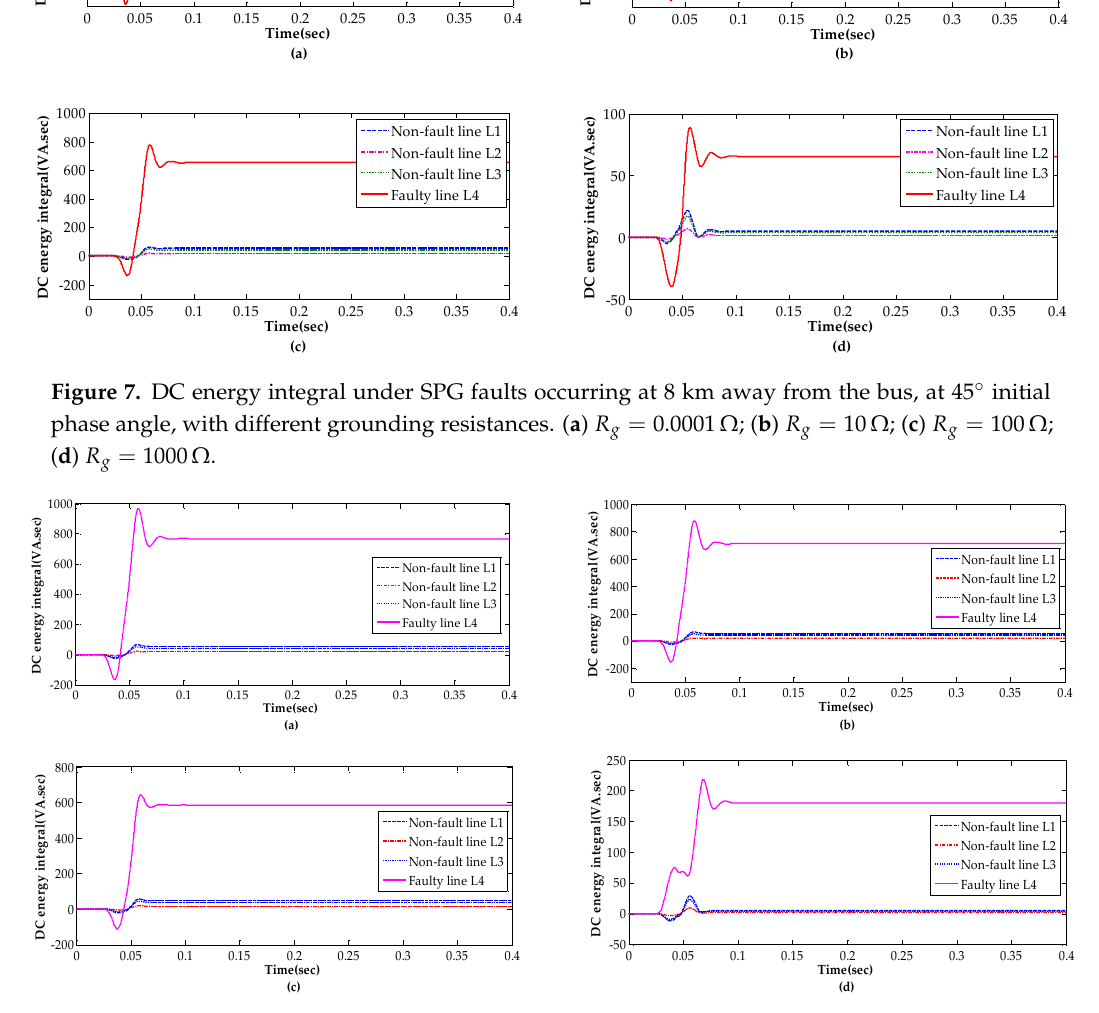
Figure 8. DC energy integral under SPG faults occurring at 8 km away from the bus, grounded through a resistance of 100 Ω , with different initial phase angles. ( a ) θ = 0 ◦ ; ( b ) θ = 30 ◦ ; ( c ) θ = 60 ◦ ; ( d ) θ = 90 ◦